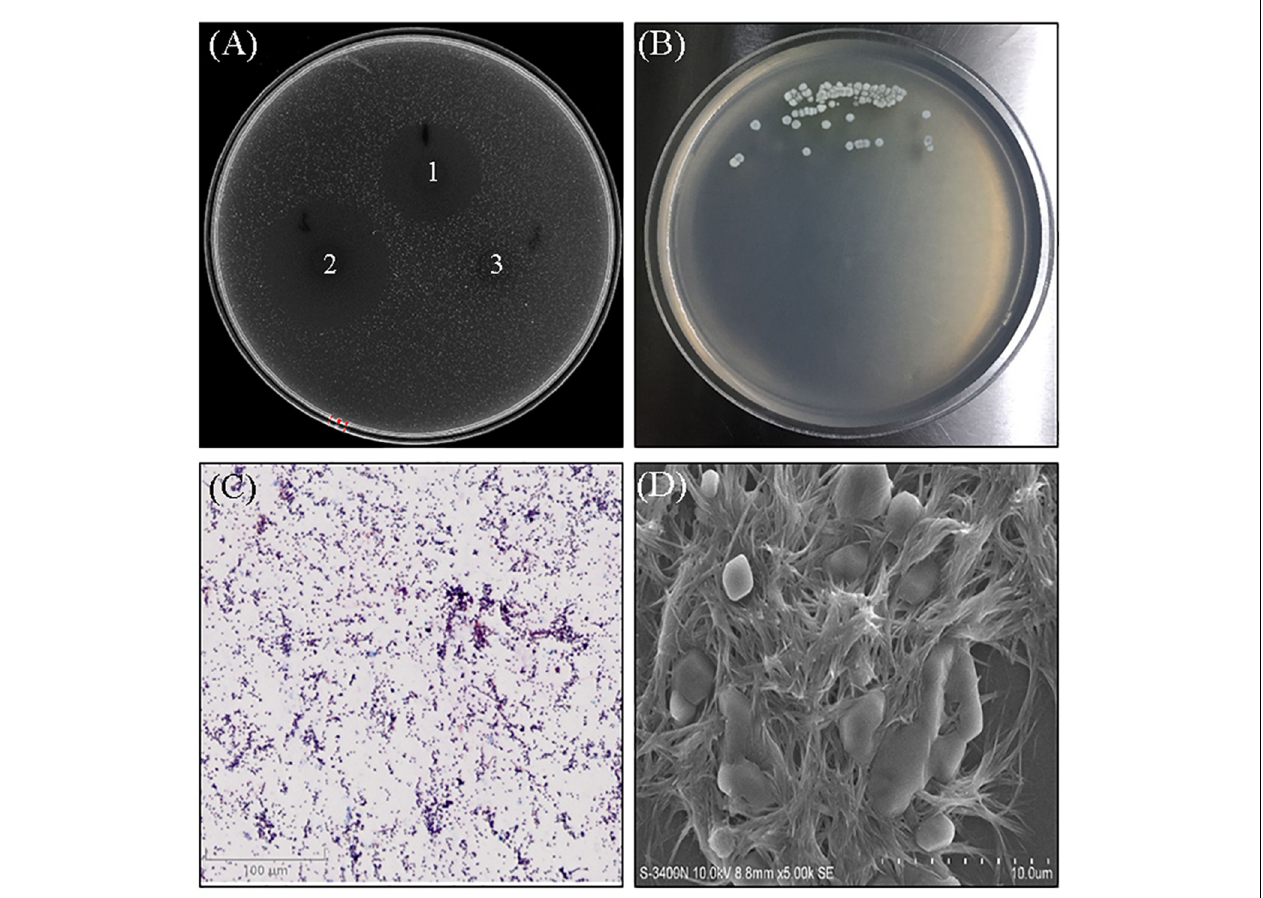
FIGURE 1 | The anti-MRSA activity, morphological characteristics of strain WA5-2-37. (A) The anti-MRSA activity of WA5-2-37, 1–3 refers to sample, positive control and blank control. The concentrations of sample and positive control were both 100 µ g/mL and the experiment was performed in triplicate. (B) Culture on Gause’s synthetic agar no. 1. (C) Observation of the culture under optical microscopy following Gram staining (100 × ). (D) Observation of the culture by scanning electron microscopy (5,000 ×